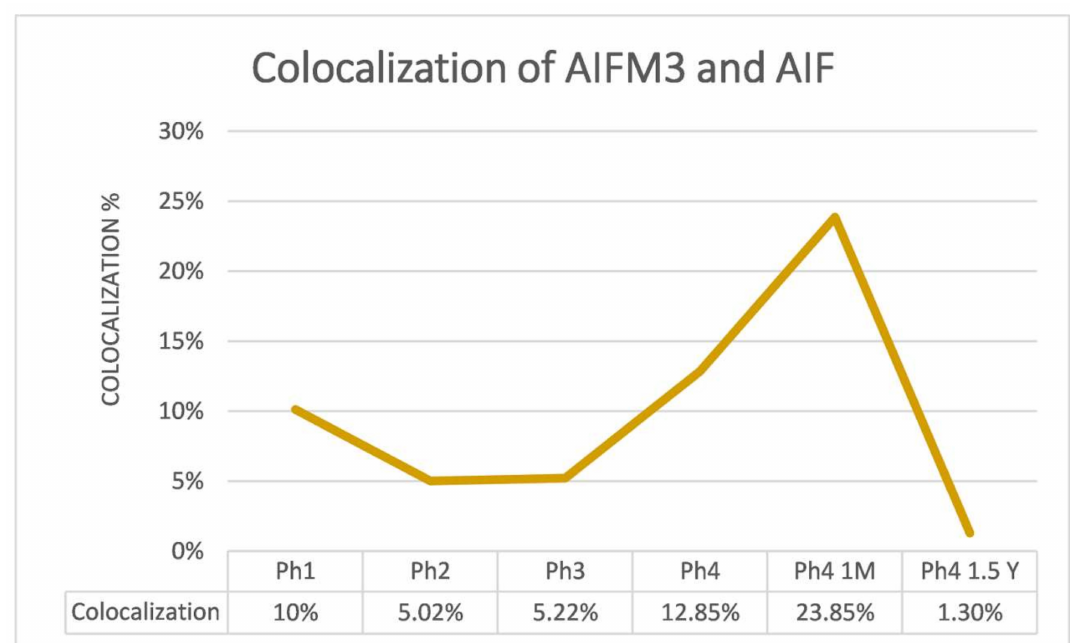
Figure 7. Colocalization values presented as percentages in graph and table form. Phase one (Ph1), phase two (Ph2), phase three (Ph3), phase four prenatal (Ph4 pre), phase four one month postnatal (Ph4 1 M), and phase four one and a half years postnatal (Ph4 1.5